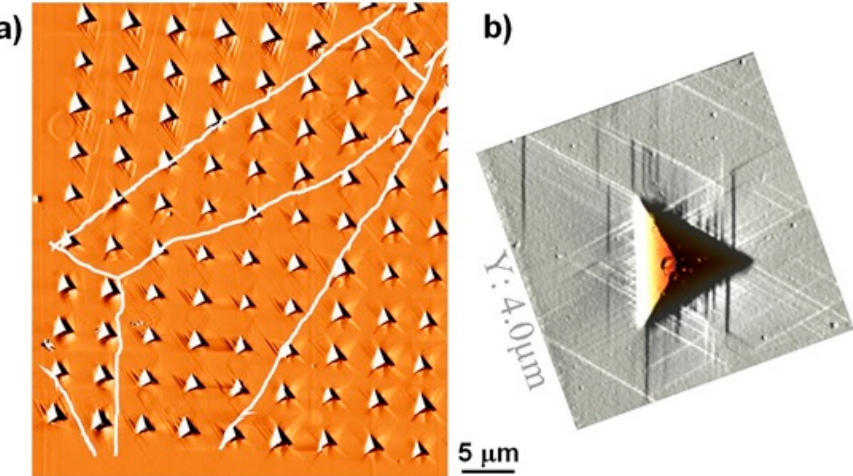
Figure 2. ( a ) Set of twelve overlapped atomic force microscopy (AFM) images (error signal mode) exhibiting the main plastic deformation mechanisms around the residual imprints. ( b ) AFM image of one indentation.